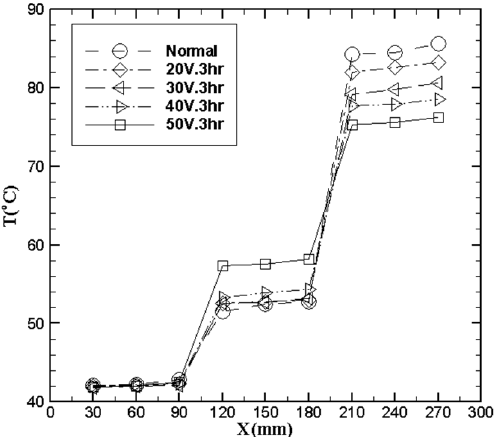
Figure 4. Temperature distributions under an input heat power of 100 W for different anodizing voltages at a treatment time of 3 h. voltages at a treatment time of 3 h.